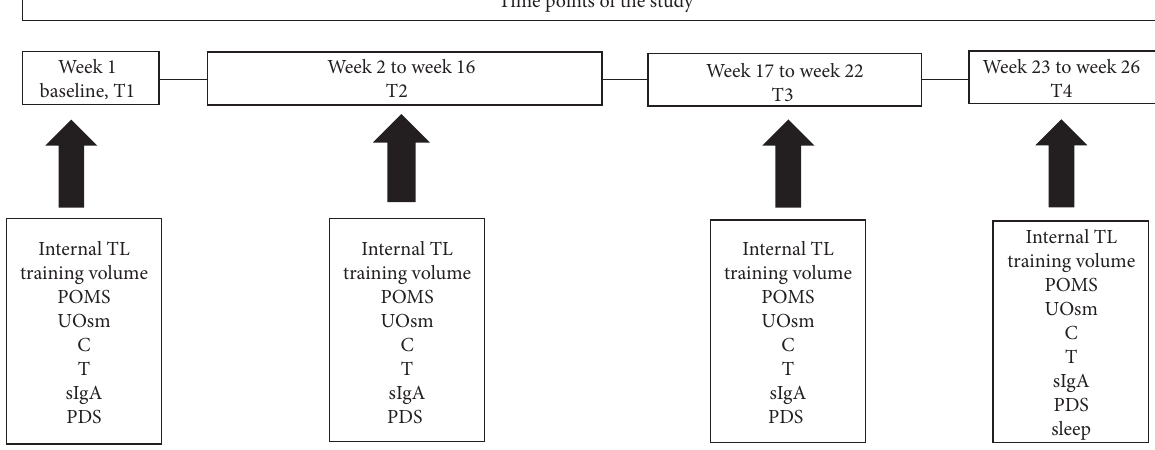
Figure 1: Schematic overview of the study